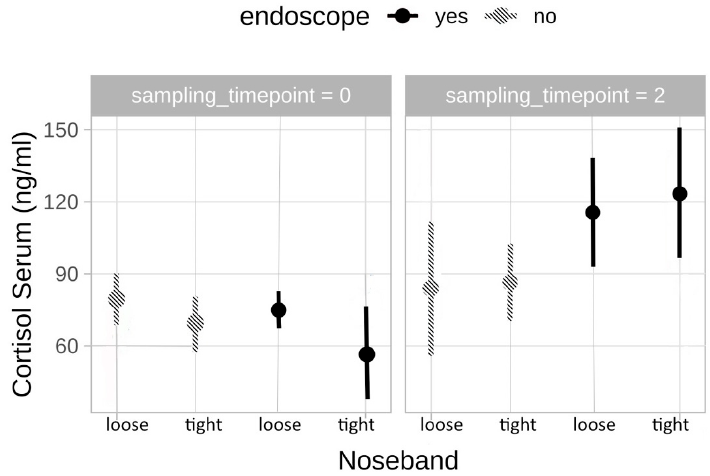
Figure 2. Cortisol in correlation with the different stress levels (level 1 = loose noseband, no endoscope, level 2 = tight noseband, no endoscope, level 3 = loose noseband plus endoscope, level 4 = tight noseband plus endoscope) at timepoint 0 (t0) and 2 (t2) after riding (n = 16). There was a significant increase between stress level 2 and 3 ( p = 0.039), stress level 1 and 4 ( p = 0.043) and as stress level 2 and 4 ( p = 0.020).